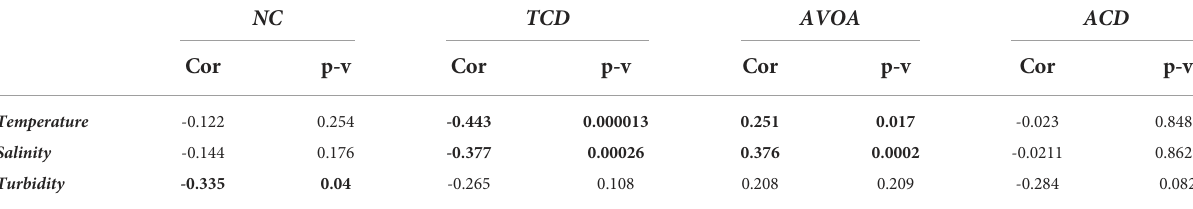
TABLE 2 Correlations between the M. edulis gaping behaviour and the variability of physical and chemical parameters measured in the natural seawater from the head tank.